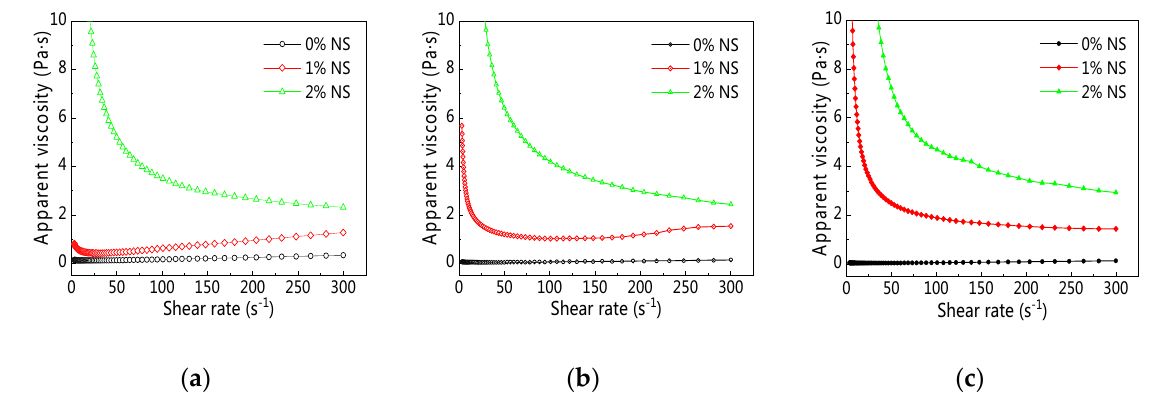
Figure 9. Apparent viscosity vs. shear rate under different NS content and resting time. ( a ) 5 min; ( b ) 60 min; ( c ) 120 min.